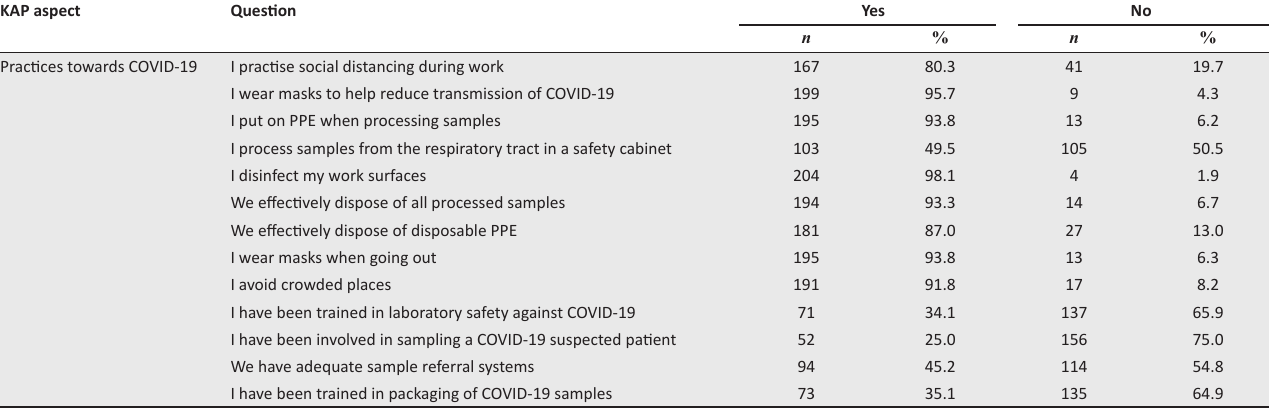
TABLE 3 : Characteristics of responses for knowledge and practice towards COVID-19, Zambia, June 2020. † KAP aspect